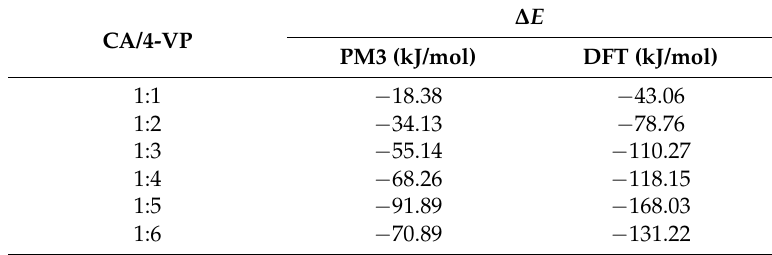
Table 1. Binding energies of chlorogenic acid (CGA) with 4-vinylpyridine (4-VP) in different molar ratio. CA/4-VP